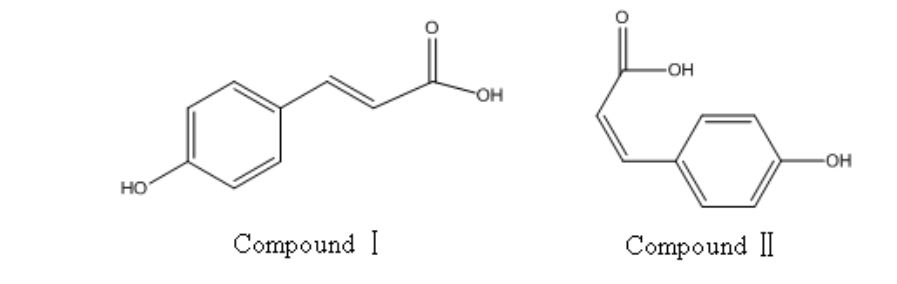
Figure 6. Structures of compound I and compound